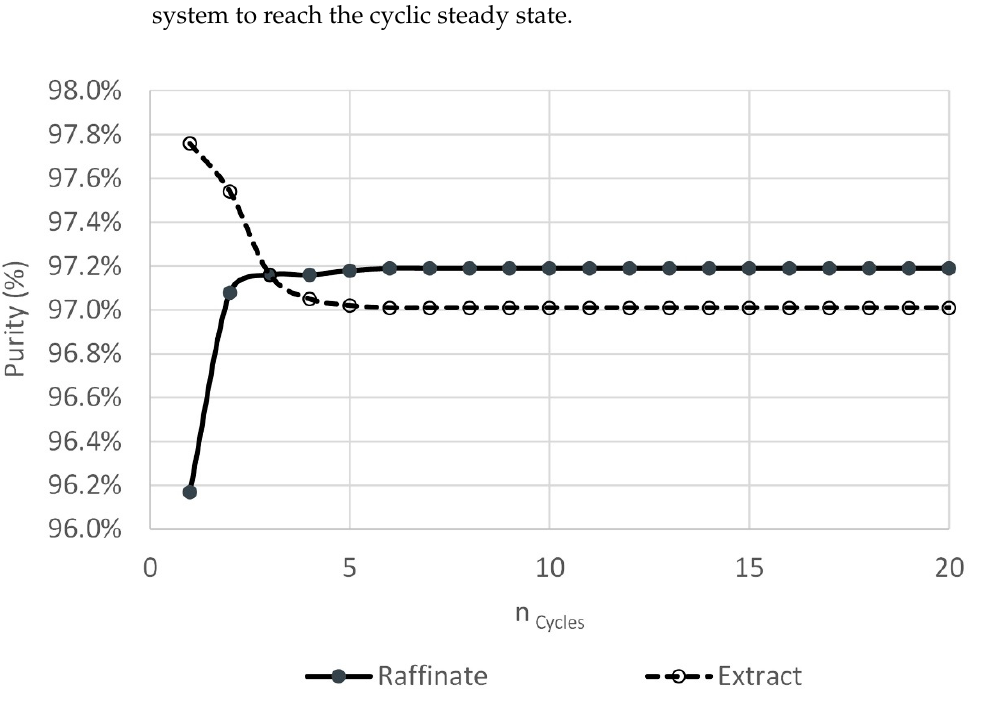
Figure 7. Outlet streams’ purity histories over the number of cycles.